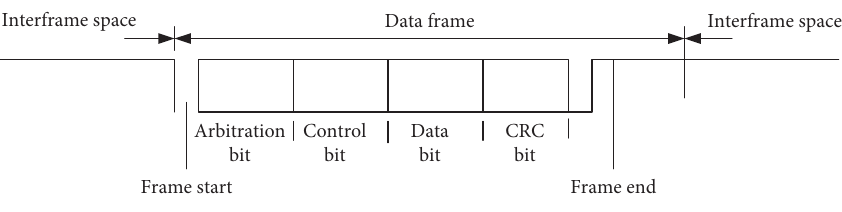
Figure 3: Structure of data